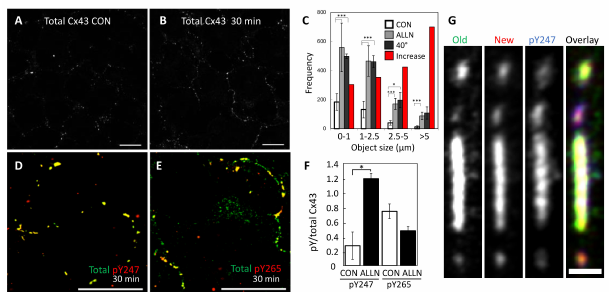
Figure 7. Immunofluorescent staining of LA25 cells for total Cx43 (Cx43IF1) in the absence ( A ) or presence of a proteasomal inhibitor ( B ) and the resulting quantification of junction size ( C ) comparing control to the proteasomal inhibitor ALLN (red bars indicate the percent increase elicited by proteasome inhibition) and cells incubated at 40 ◦ C (src inactive). In ( D , E ), cells were stained for total Cx43 (green, Cx43IF1) and pY247 (D, red) or pY265 (E, red), resulting overlay is yellow, and the ratios are indicated in ( F ). G shows a higher magnification view of a large gap junction showing old, new, and pY247 subdomains. A, B, D, F Mag bars are 20 µ m, G is 1 µ m. * and *** indicate p < 0.05 and p < 0.001,